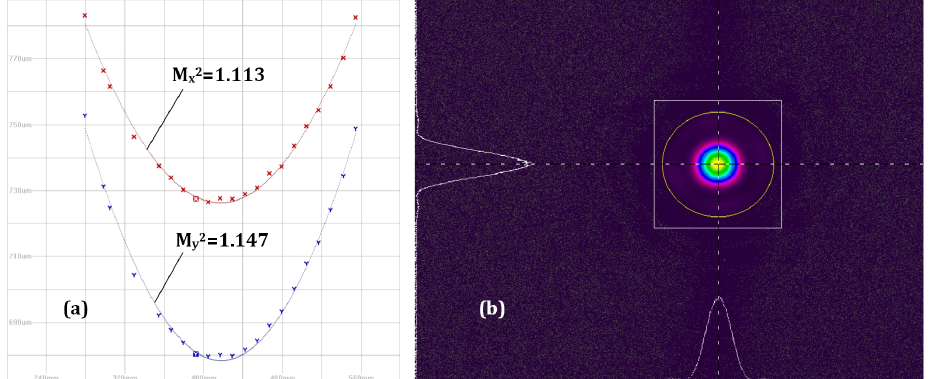
Figure 6. ( a ) experimental output laser beam quality; ( b ) spatial mode profile measuring via a laser beam analyzer in the stable Q-switched